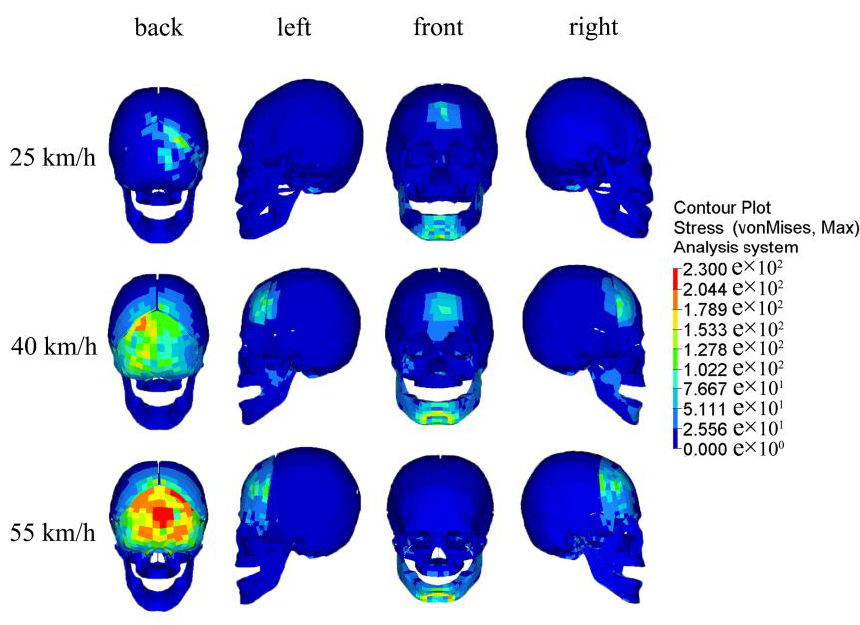
Figure 6. The Von Mises stress cloud on the skull at different collision parameters.